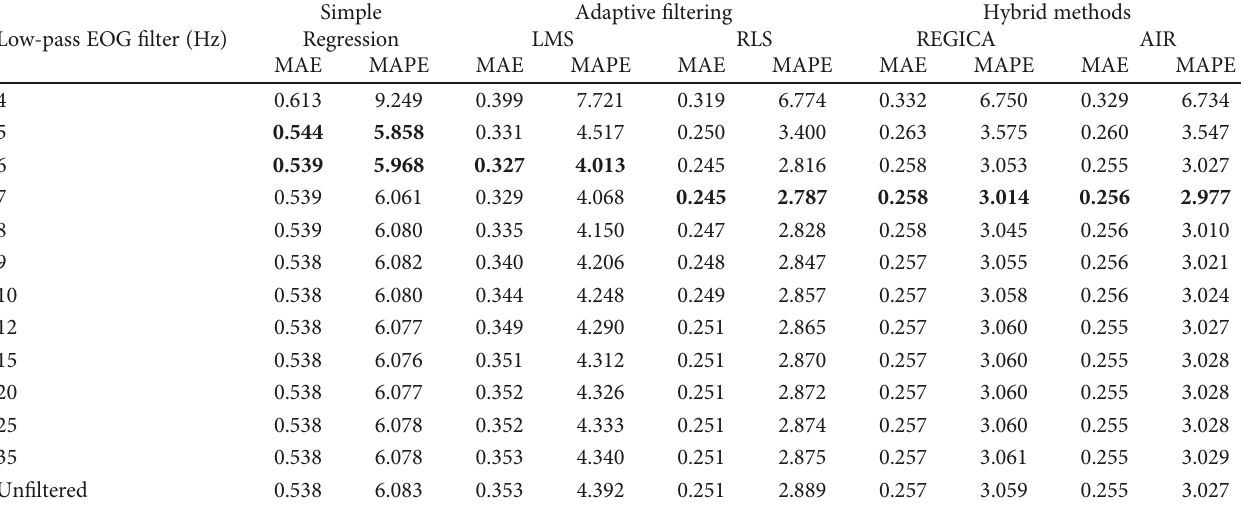
Table 6: Mean absolute error (MAE) and mean absolute percentage error (MAPE) values in delta frequency band (mean of all EEG